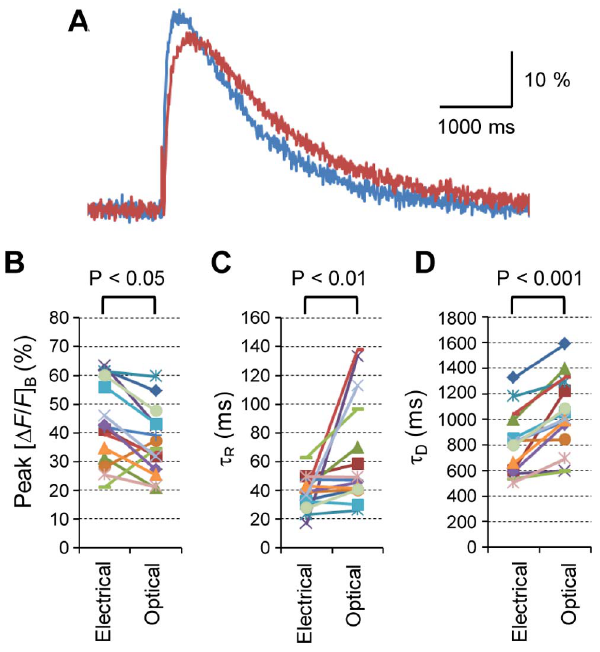
Figure 5. The intracellular Ca 2 + transient induced by direct optogenetic stimulation of the presynaptic terminal. A , Sample [ D F/F ] B of R-GECO1 responses evoked either by electrical stimulation of the oculomotor nerve (blue) or by direct photostimulation of the presynaptic terminal (red). The same calyx-type presynaptic terminal in the presence of 4-AP (1 mM). B – D , Quantitative comparison of Ca 2 + transients between electrical stimulation and optogenetic stimulation: the peak [ D F/F ] B ( B ), time constant of the rising phase ( t R , C ) and that of the decaying phase ( t D , D ). Each symbol indicates an individual presynaptic